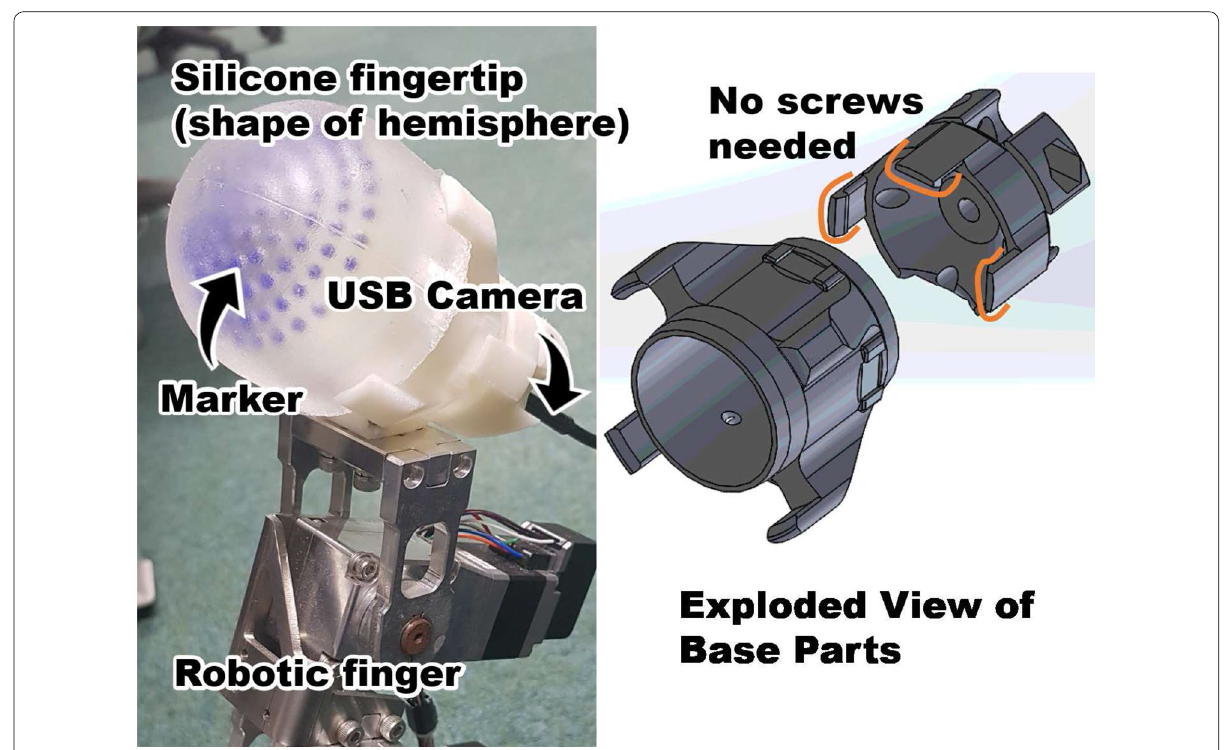
Fig. 1 Visual‑tactile sensor and the exploded view of base